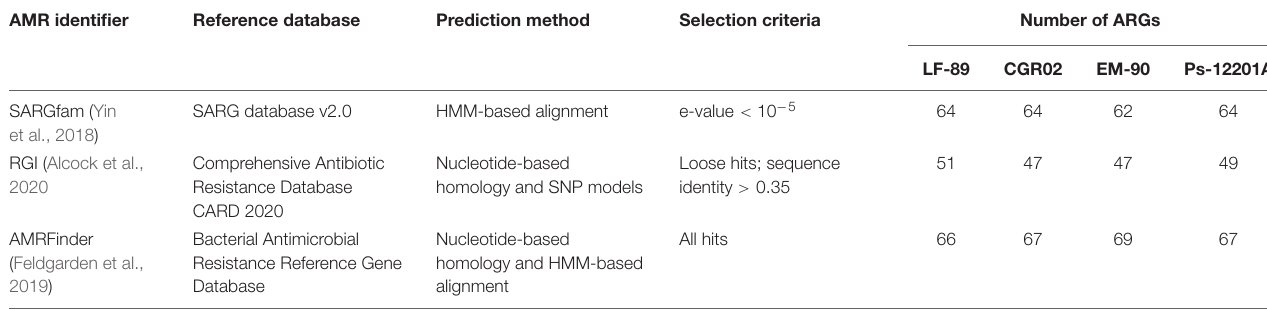
TABLE 1 | Summary of bioinformatics tools used for predicting ARGs in the genome of four P. salmonis